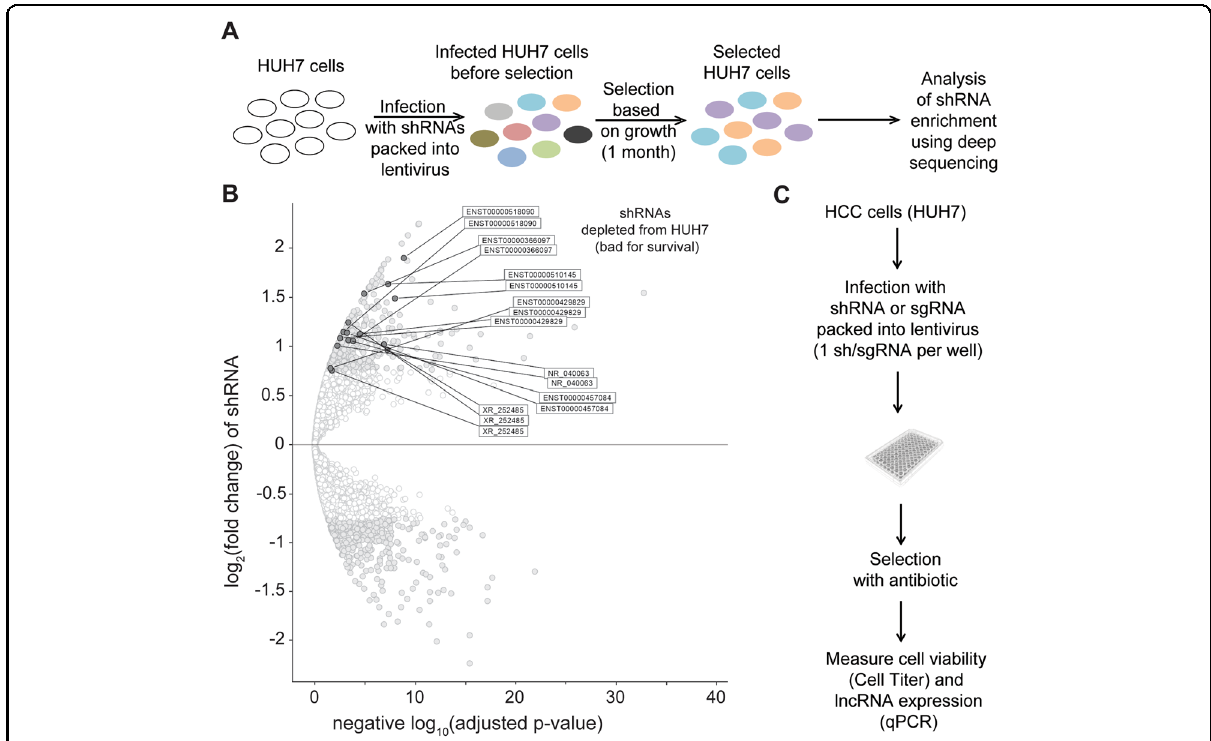
Fig. 1 Experimental design and selection strategy for the identi fi cation of lncRNAs essential for HUH7 HCC cell survival. A Schematic work fl ow of the survival-based pooled shRNA library screen in HUH7 cells. shRNAs were designed to target lncRNAs identi fi ed in the cell line. B Volcano plot of the differentially expressed shRNAs in the fi nal population of HUH7 cells. The x -axis indicates the adjusted p -values plotted in − log 10 . The y -axis indicates the log 2 (fold change) in shRNA expression, which was de fi ned as the ratio of normalized shRNA expression in the input library over the fi nal HUH7 population. Light gray dots represent shRNAs with log 2 (fold change) ≥ 0.75 and adjusted p -value ≤ 0.05. Dark gray dots represent shRNAs of lncRNAs for which at least two shRNAs have log 2 (fold change) ≥ 1 and adjusted p -value ≤ 0.05 or lncRNAs for which at least three shRNAs have log 2 (fold change) ≥ 0.75 and adjusted p -value ≤ 0.05. C Schematic work fl ow of arrayed shRNA and sgRNA screens used for validation of lncRNAs identi fi ed in B